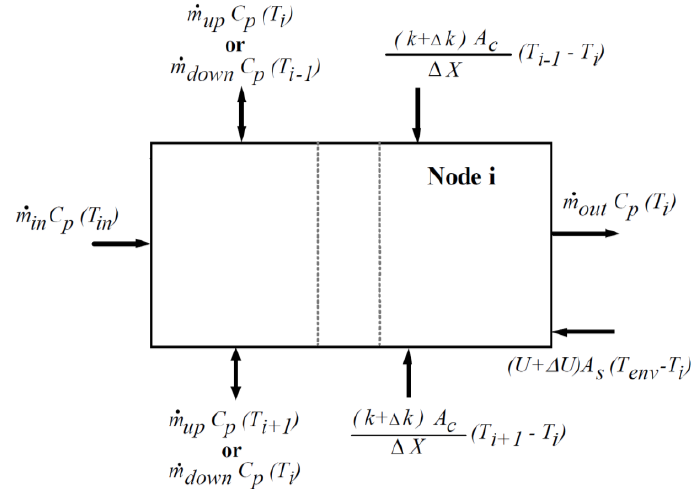
Figure 4. Graphical Representation of Energy Flows into a Node.